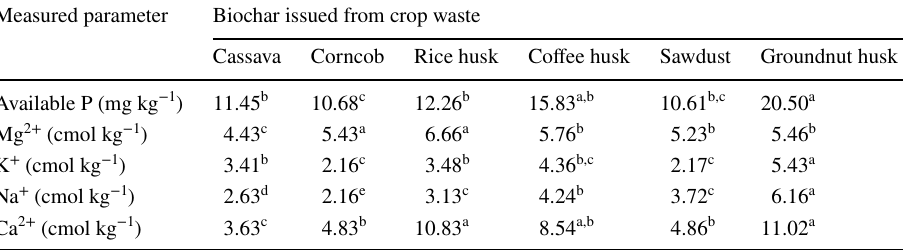
The letters in superscript compare means of the different biochars. The same letters in a row are not signifi- cant according to Tukey test at P